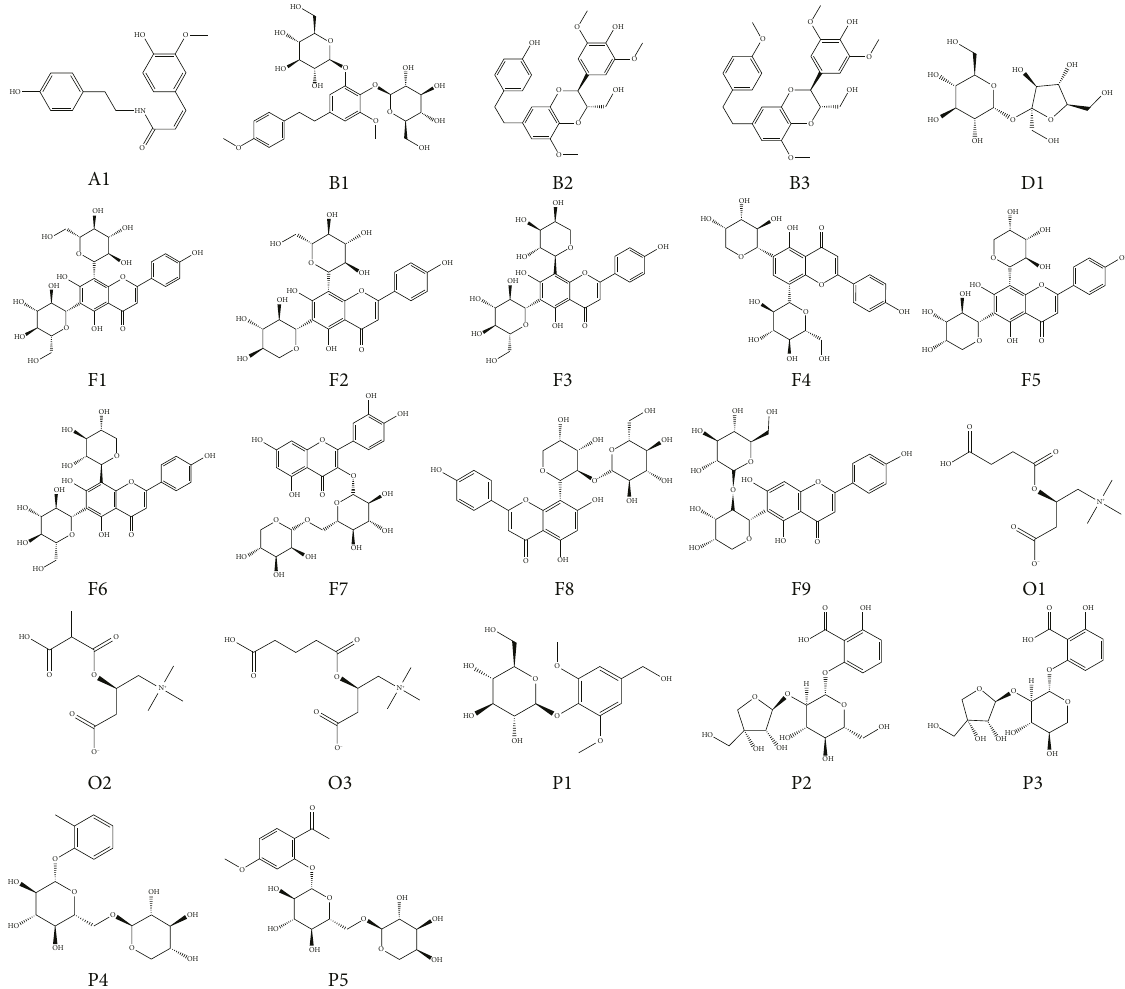
Figure 4: Chemical structures of diferential compositions in D. ofcinale from four